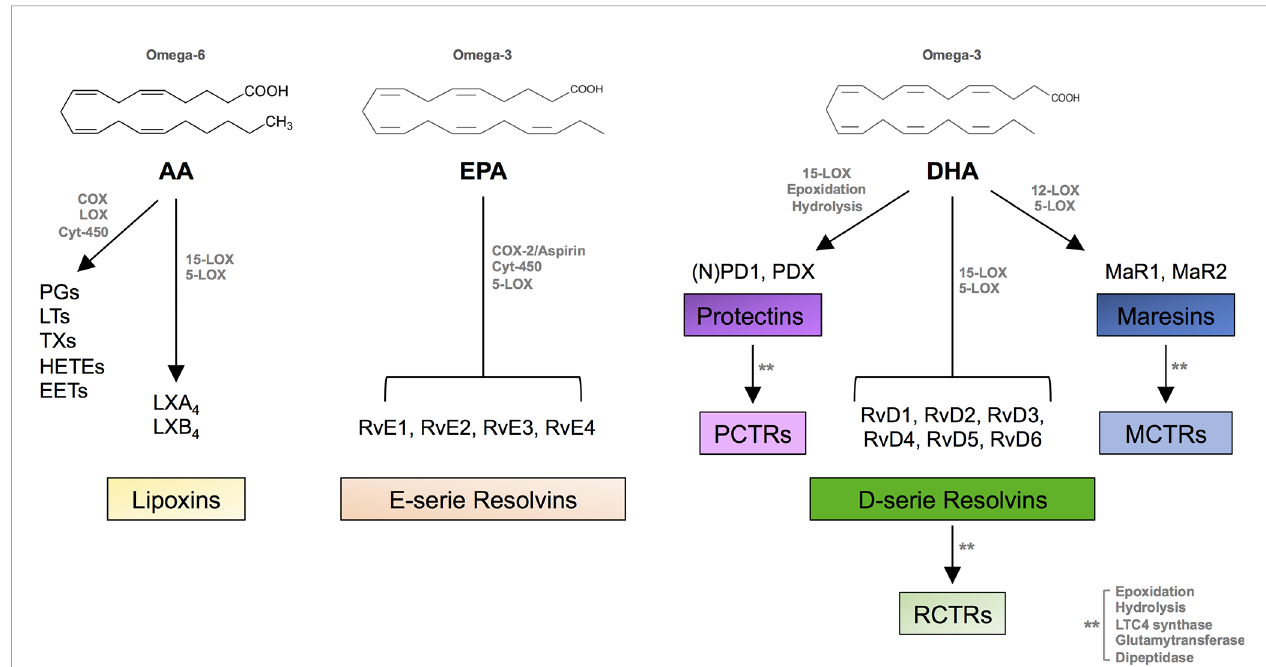
FIGURE 1 | SPM biosynthesis. Chemical structures of AA, EPA, and DHA and outline of the individual families of the main pro-in fl ammatory eicosanoids and SPMs biosynthesized from these PUFAs. AA, arachidonic acid; COX, cyclooxygenase; LOX, lipoxygenase; Cyt, cytochrome; PGs, prostaglandins; LTs, leukotrienes; TXs, thromboxanes; EETs, epoxy eicosatrienoic acids; HETEs, hydroxy eicosatetraenoic acids; Rv, resolvin; PD, protectin; MaR, maresin; PCTR, protectin conjugates in tissue regeneration; RCTR, resolvin conjugates in tissue regeneration; MCTR, maresin conjugates in tissue